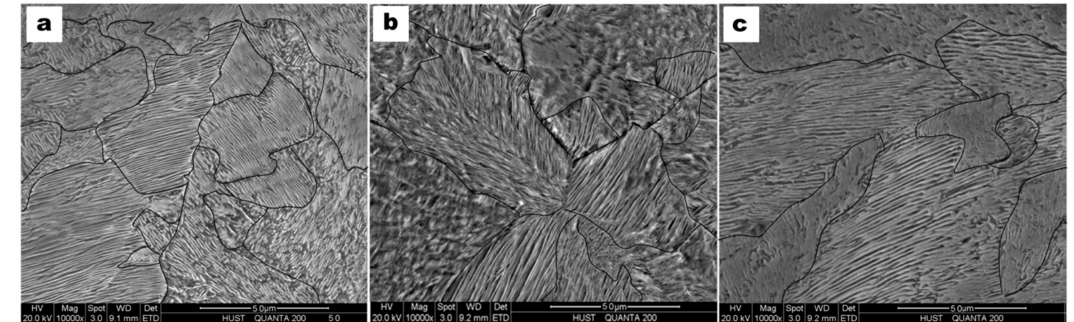
Figure 12. Pearlite colony size at di ff erent cooling rates. ( a ) 4 ◦ C / s. ( b ) 3 ◦ C / s. ( c ) 1 ◦ C /